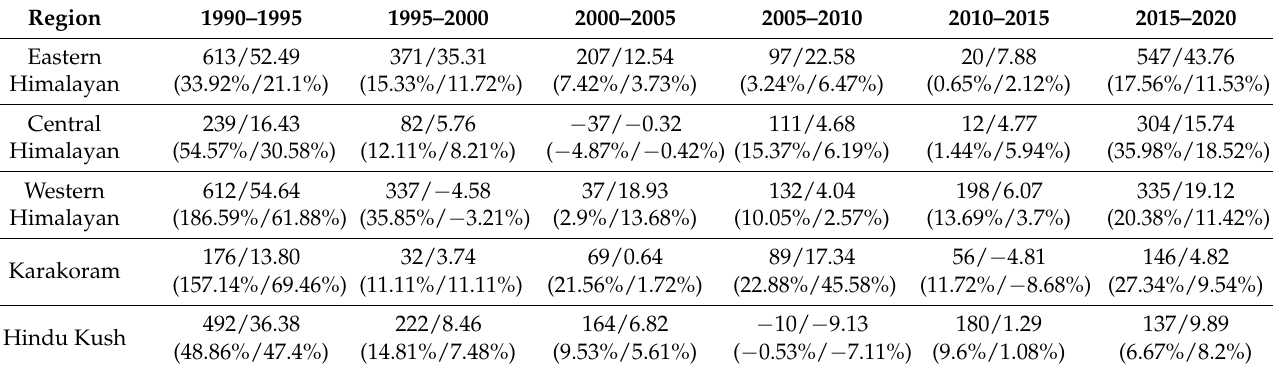
Figure 13. Changes in glacial lake number and area in five mountain ranges from 1990 to 2020. Table 4. Number and area (km 2 ) changes in glacial lakes in five mountain ranges from 1990 to